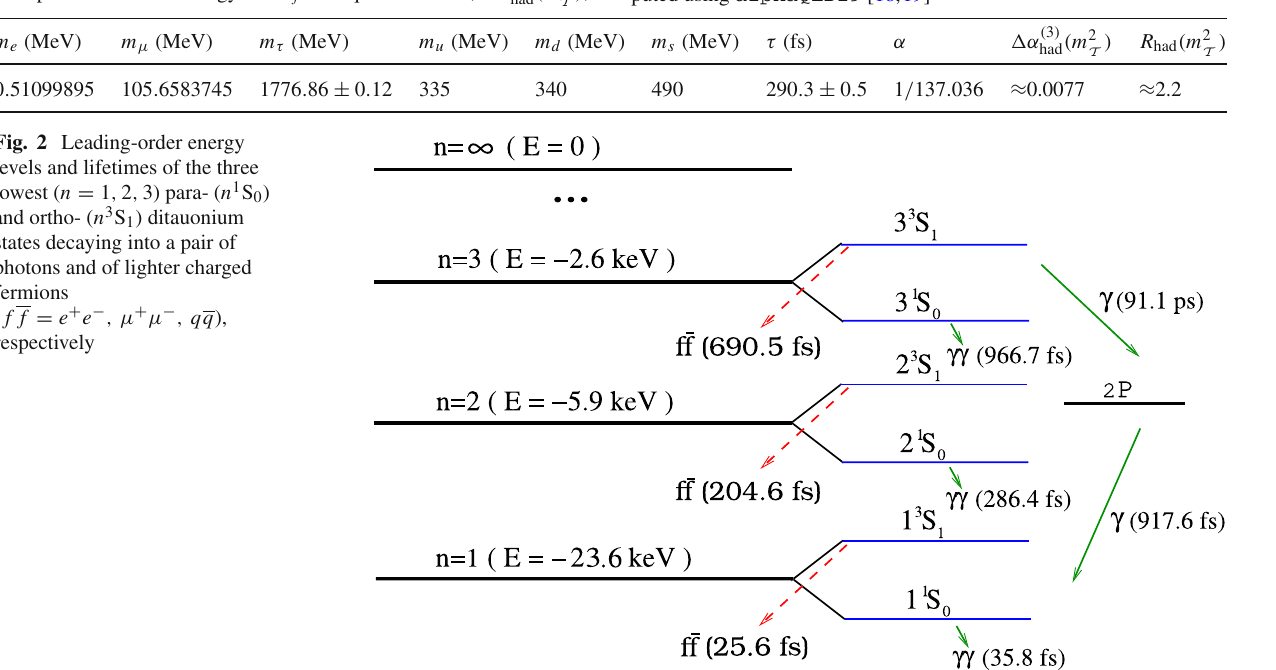
( 3 ) ( m 2 ) is com- had T